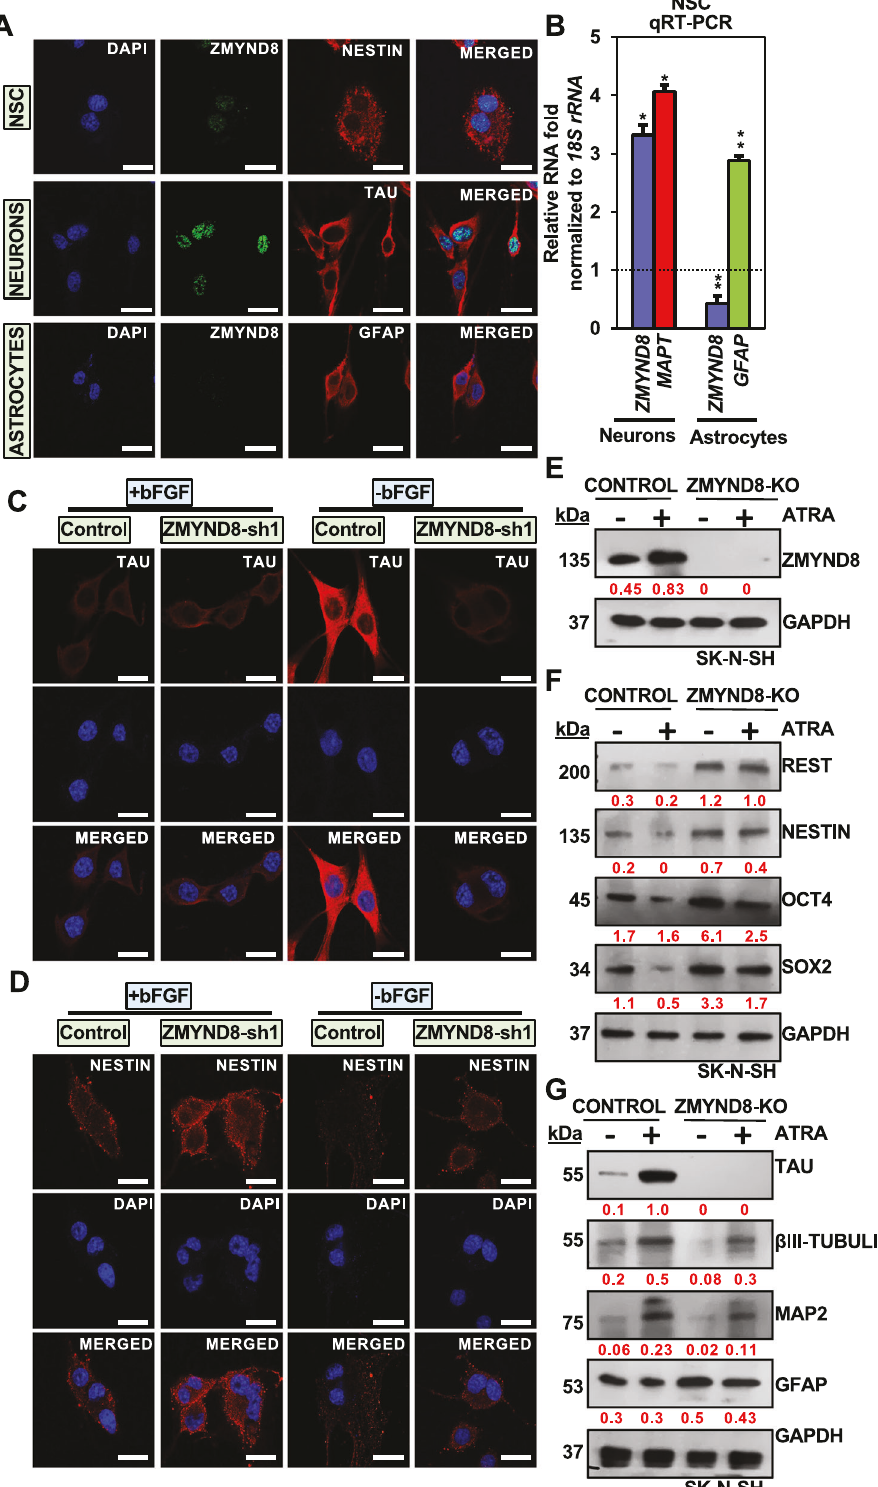
Fig. 1 ZMYND8 regulates neuronal differentiation. A , B ZMYND8 expression in NSCs, neurons, and astrocytes by immuno fl uorescence ( A ) or qRT-PCR ( B ). NESTIN, TAU, and GFAP serve as pluripotency, neuronal and glial markers, respectively. The scale bar indicates 20 μ m. C , D Immuno fl uorescence showing expression of TAU (neuronal) ( C ) or NESTIN (pluripotency) ( D ) in ZMYND8 knockdown-induced neurons differentiated from NSCs. The scale bar indicates 20 μ m. E – G Immunoblot blot analysis showing expression of ZMYND8 ( E ), pluripotency marker ( F ), and neuronal differentiation marker ( G ) in ZMYND8 -knockout ( ZMYND8 -KO) or control SK-N-SH cells with or without ATRA treatment. GAPDH serves as a loading control. The immunoblots are quanti fi ed and represented as numerical, re fl ecting the band intensity normalized to loading control. Error bars indicate sem.; n = 3; three independent experiments. A two-tailed t -test was used to calculate P - values. * P < 0.05; ** P < 0.01. Cell Death and Disease (2022)